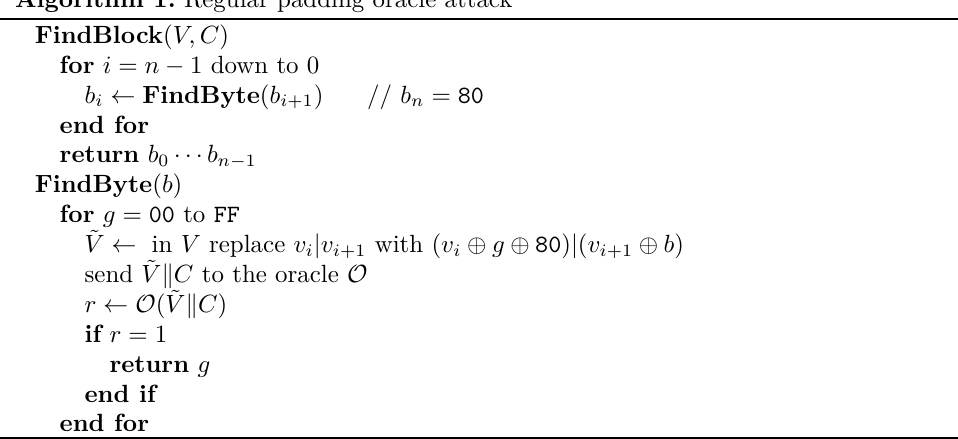
Algorithm 1: Regular padding oracle